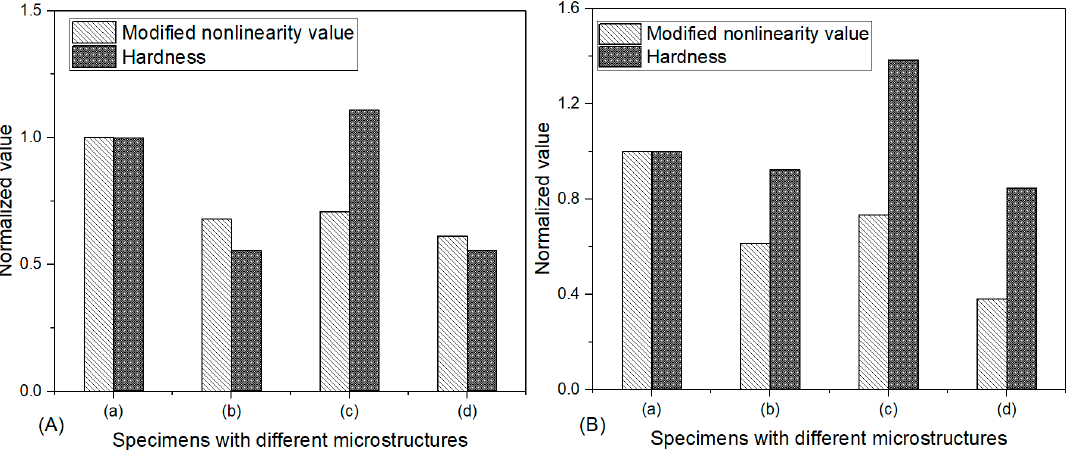
Figure 10 . Variations of acoustic nonlinear response ( 𝛽̅ (cid:3030) ) in ( A ) copper and ( B ) brass with different microstructures